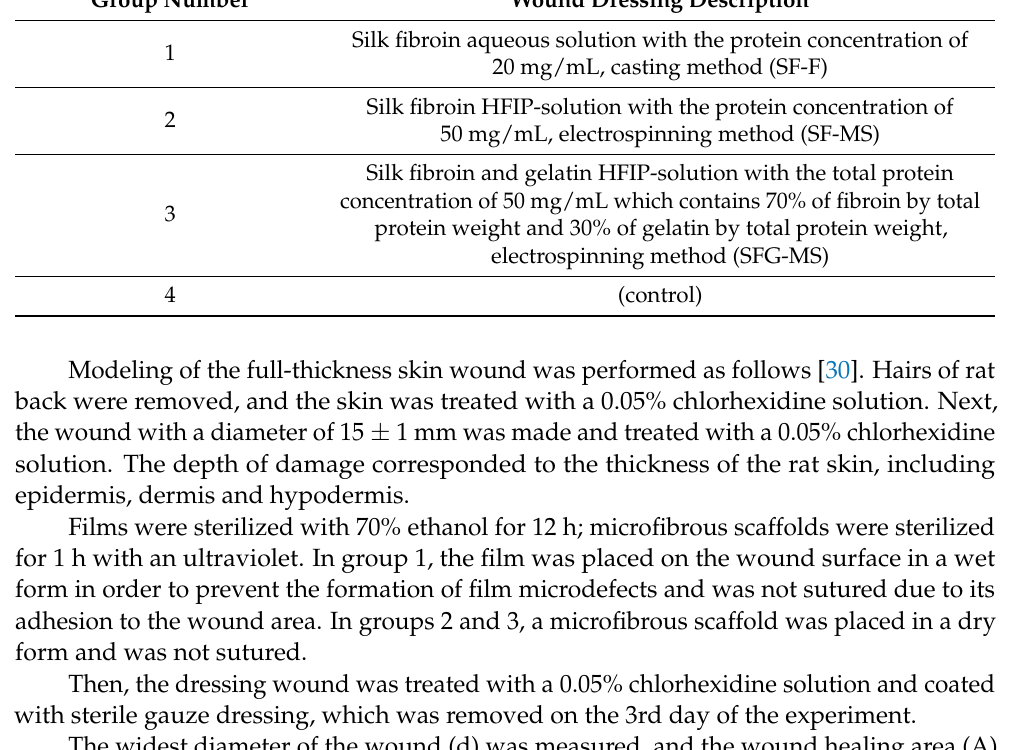
Table 1. Description of the experimental groups. The number of animals in each group was 5. Group Number